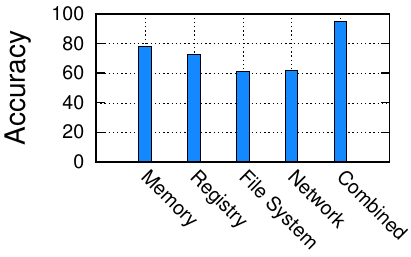
Figure 1. The accuracy of classifying